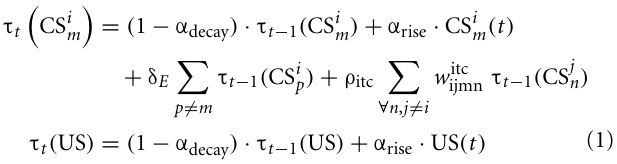
FIGURE 1 | (A) A trial in DMTS training. A sample stimulus is presented during 500ms, a 1-s delay is interposed, and after that delay two comparison stimuli are presented.The subject must choose between these stimuli in order to receive a reward. In this trial, letters were paired to colors. (B) A DMTS trial where letters are paired to words. (C) A test trial where unpaired stimuli are presented, it is a test for equivalence relation between words and